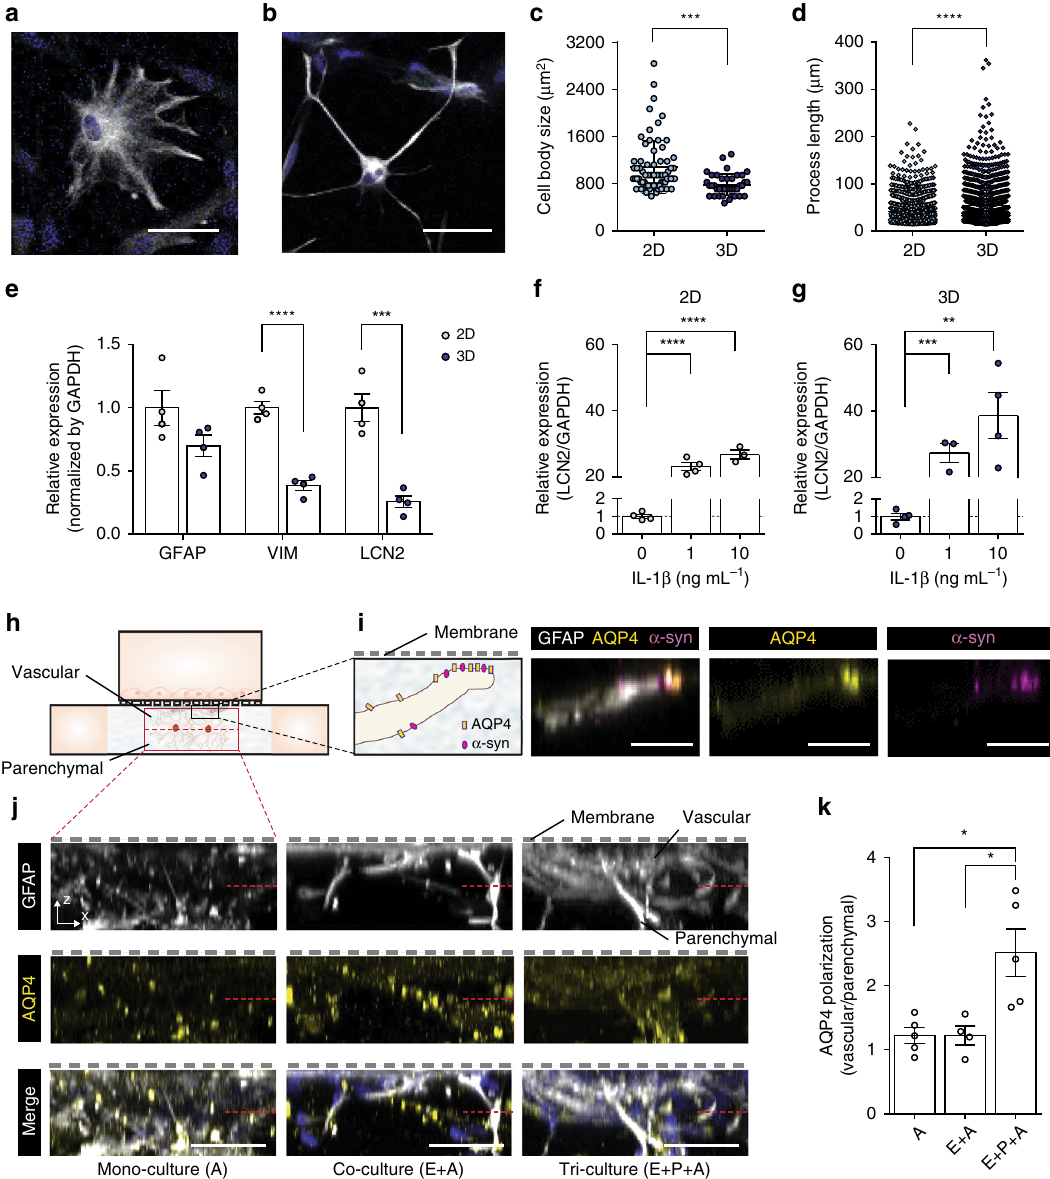
Fig. 3 3D culture of astrocytes with AQP4 polarization in the BBB chip. a , b Representative morphology of human astrocyte (HA) cultured on a Matrigel- coated 2D surface ( a ) and in 3D Matrigel ( b ) (GFAP, white; DAPI, blue) (scale bars = 50 µ m). c Cell body size of HAs cultured in 2D and 3D ( n = 69 for 2D and 39 for 3D, *** p < 0.005 by student t -test). d Process length of HAs cultured in 2D and 3D ( n = 1352 for 2D and 1302 for 3D, **** p < 0.001 by student t -test). e Gene expression of reactive gliosis markers in HAs cultured in 2D and 3D ( n = 4 for each condition, *** p < 0.005 and **** p < 0.001 by student t -test). f , g Gene expression of lipocalin-2 (LCN2) in HAs cultured on a Matrigel-coated 2D surface ( f ) and within 3D Matrigel ( g ) with interleukin- 1 β (IL-1 β ) treatment demonstrating the ability to model reactive astrocytes more effectively in 3D ( n = 4 for each condition, ** p < 0.01, *** p < 0.005, and **** p < 0.001 by student t -test). h Quantitative analysis of AQP4 polarization by measuring AQP4 distribution in vascular and parenchymal side in the perivascular channel. i Co-localization of AQP4 (AQP4, yellow) and α -syn ( α -syn, magenta) at astrocytic end-feet (scale bars = 20 µ m). j Distribution of AQP4 (AQP4, yellow) along the cell bodies of HAs (GFAP, white; DAPI, blue) in the channel (scale bars = 50 µ m). k Polarized expression of AQP4 to the vascular side in the perivascular channel ( n = 4 for each condition, * p < 0.05 by student t -test). Data are presented as mean ± s.e.m. All images are representative ones from at least fi ve biological and three technical only establishing a 2D intact brain endothelium and recon- but also connecting the BBB cells in perfusable proximity for their intercellular signaling in co-culture. Moreover, the side channels along with the 3D brain microenvironment allowed for a precise quanti fi cation of NP distributions across the BBB. cell source to mimic organ-speci fi c fuction in vitro, as well as for